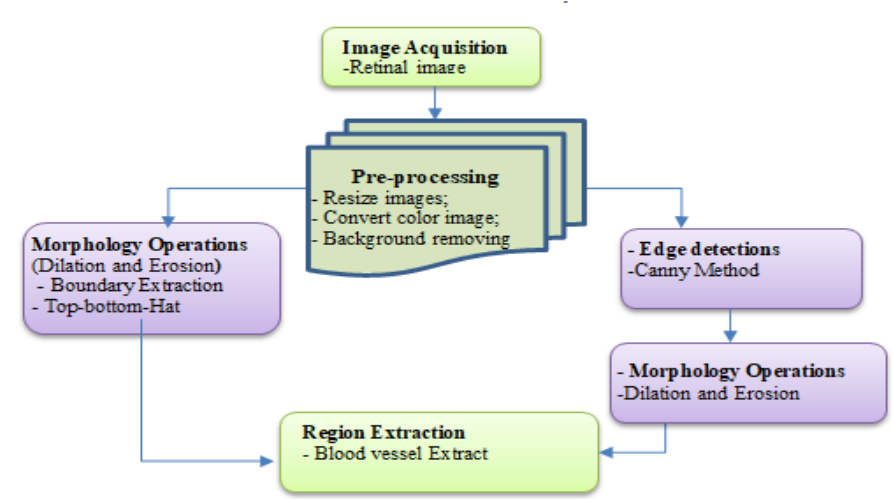
Fig. 3: Block diagram of the proposed